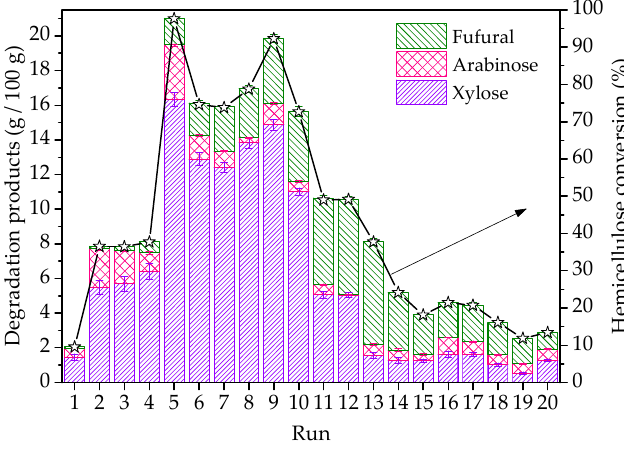
Figure 6. Effect of 1 × 10 − 5 mol/L FeCl 2 pretreatment on hemicellulose degradation. Figure 6. E ff ect of 1 × 10 − 5 mol / L FeCl 2 pretreatment on hemicellulose